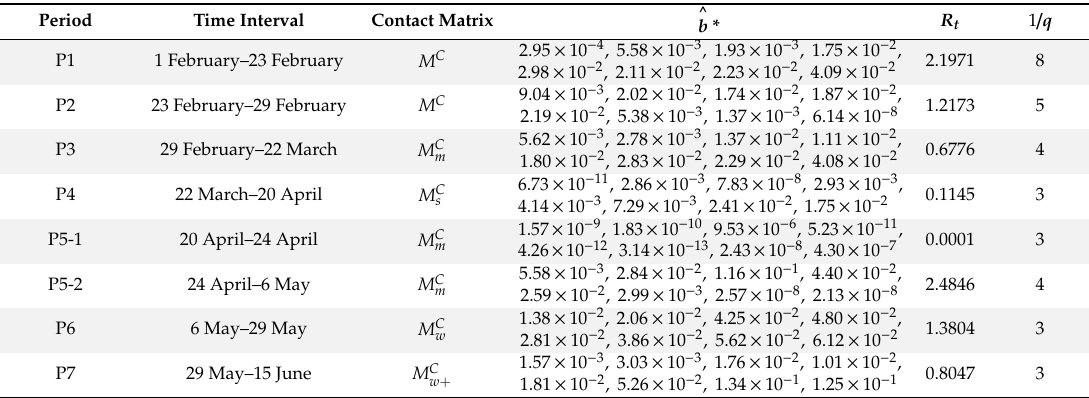
Table 5. Values of the infection probability for local transmission depending on age group and